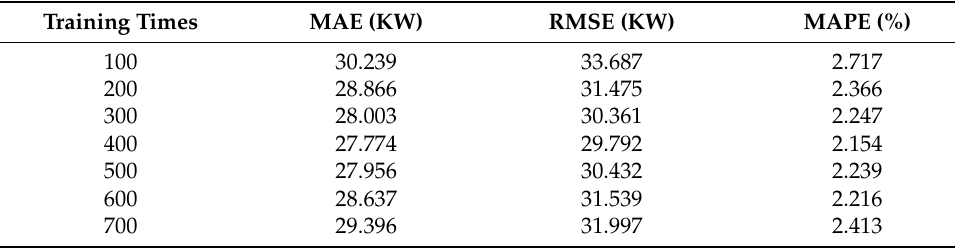
Figure 5. Typical daily load forecasting results. According to the test results in Table 2, MAE, MAPE and RMSE gradually increase after 400 training steps, which means that over fi tt ing starts to occur at 500 training steps. Therefore, the number of training steps in the LSTM model should be 400.